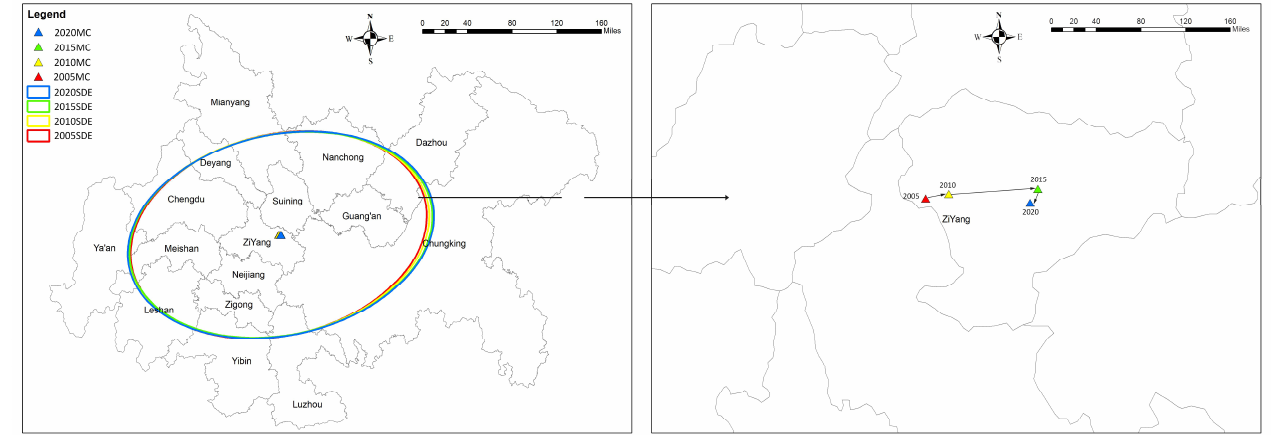
Figure 11. Coupling coordination standard deviation ellipse and center of gravity migration in CCCG, 2005–2020. Table 10. Ellipse of the standard deviation of coupling coordination and center of gravity migration parameters for the CCCG, 2005–2020.